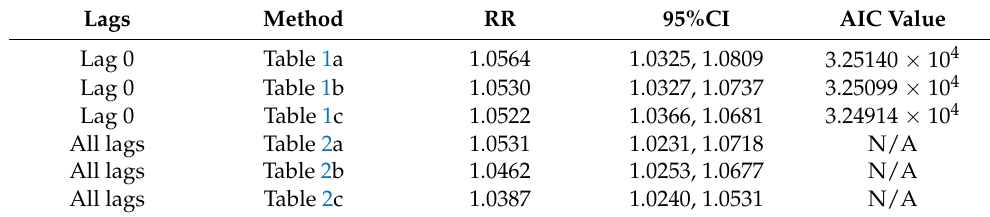
Table 3. Relative risks (RR) estimated from the presented approaches at Z = O 3 = 30